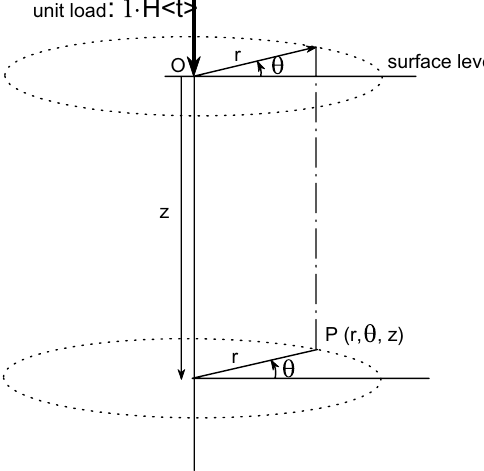
Fig. 1. Unit-step-function load normal to the horizontal surface plane of a half-space linear elastic domain, acting at a source point O on the surface, and an arbitrary field point P, described in cylindrical coordinates. the arguments, as compared to unity. The response is obtained in the time domain through manipulation of transform